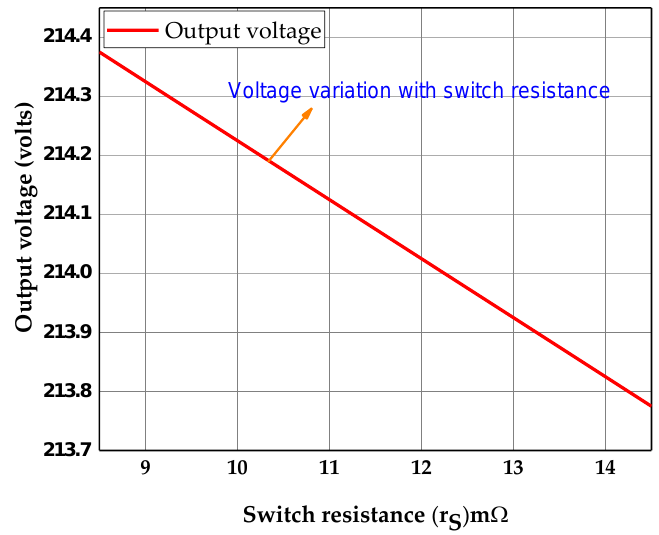
Figure 9. Variation in the theoretical output voltage with changes in r S.